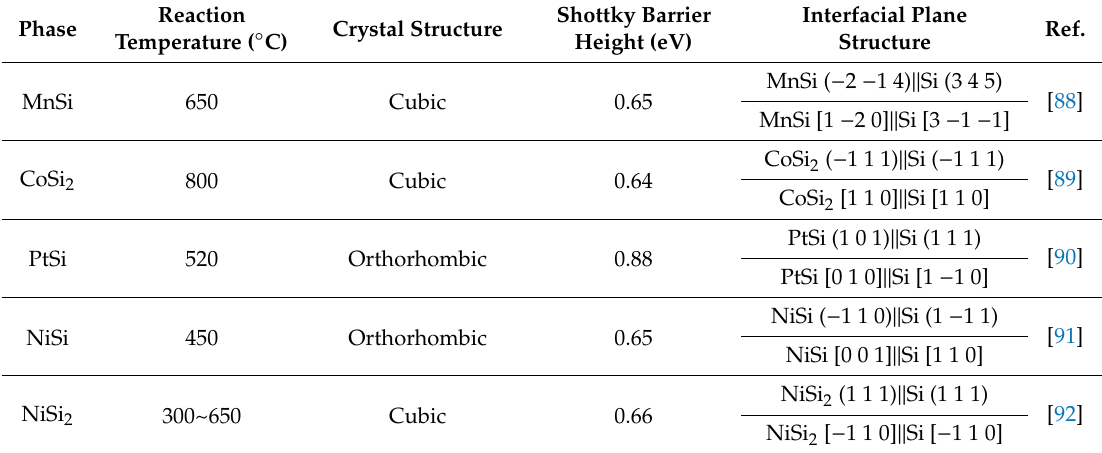
Table 1. Several typical phases in the contact formation of silicides. Reproduced or adapted from [87], with permission from Springer Nature,